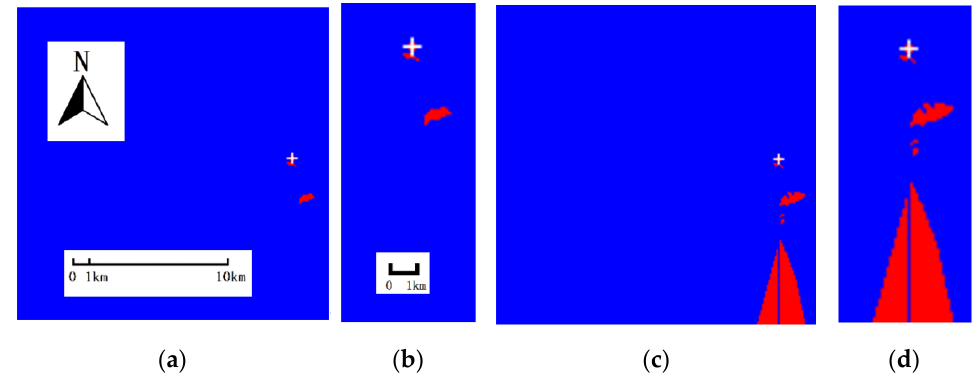
Figure 8. The viewshed results of the viewpoint at row 96, column 176 on the DEM of Malaga, Spain by different algorithms. Observer is marked with a white cross. Red area is visible and blue area is invisible. ( a ) R3, while a totally same result by every cell is figured out using HiPDERL; ( b ) Part of ( a ), row 80–200, column 150–200; ( c ) HiPDERL; ( d ) Part of ( c ), row 80–200, column 150–200.